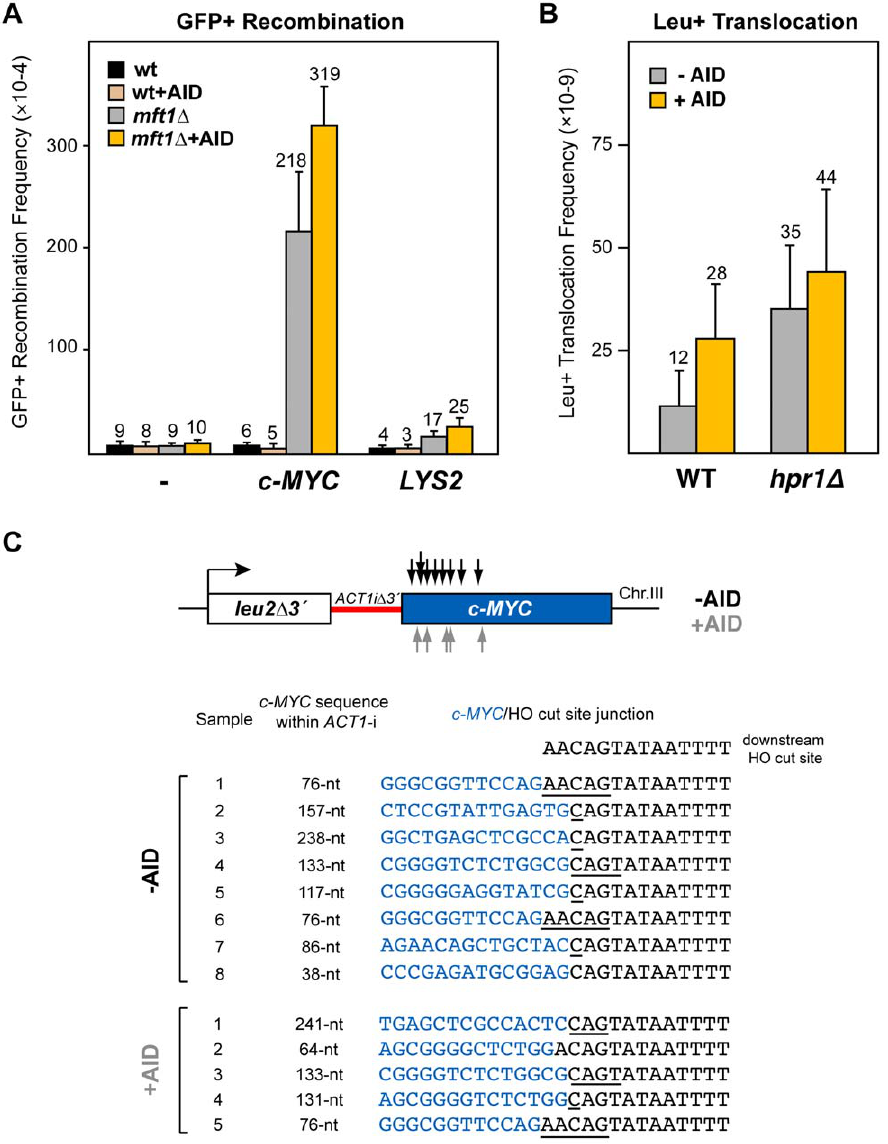
Figure 5. Analysis of recombinogenic potential of the c-MYC sequence. (A) AID-independent recombinogenic behavior of c-MYC in THO mutants. A 3.8-kb fragment of the human c-MYC , as well as the control 4.1-kb long LYS2 sequence, were cloned into the GFP-based direct-repeat recombination system. Details as in Figure 1. (B) Leu + translocation frequencies in c-MYC -containing wild-type and hpr1 D cells after HO-induced DSBs. Details as in Figure 2. (C) Analysis by PCR of CT breakpoints in hpr1 D yeast at the c-MYC sequence. Breakpoints from cells with (grey) and without (black) AID-overexpression are indicated by arrows (top). The analysis of the breakpoint junctions is shown at the bottom. The c-MYC /HO cut site junctions from eight AID- and five AID + independent Leu + translocant strains are shown. The length of the c-MYC sequence within the reconstituted ACT1 intron in the translocant chromosome is indicated. Underlined nucleotide residues indicate microhomologies between the MYC and HO cut site sequences. The sequence downstream of the HO cleavage site is shown on